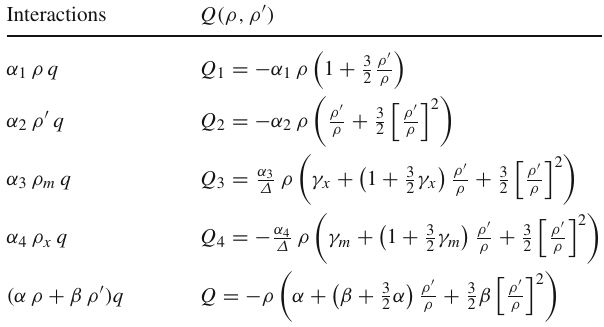
Table1 Intheleftcolumnwepresentfivesign-changeableinteractions investigated in the literature that involve the deceleration parameter q , while in the right column we write these interactions in terms of ρ and ρ (cid:2) according to (6). Here, α α and β are interaction parameters i ,